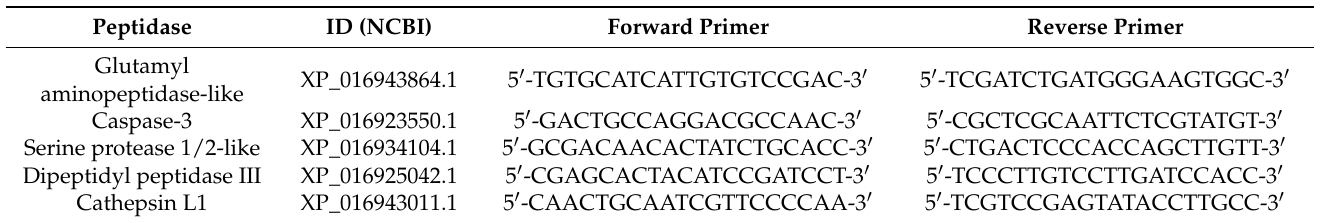
Table 1. Primers used to analyze the expression of genes encoding the D. suzukii larval